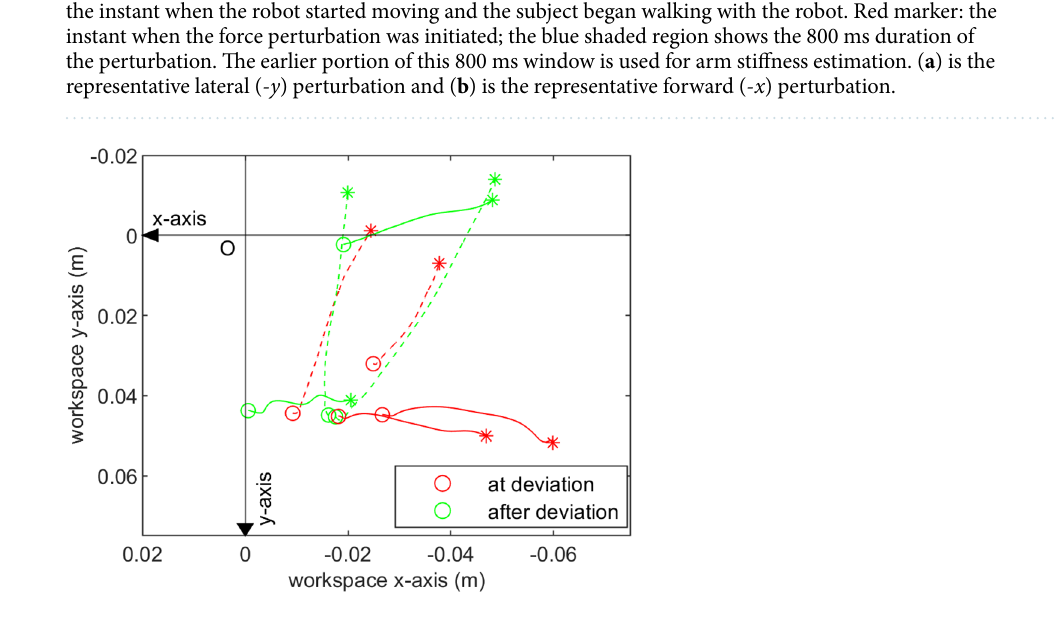
Figure 3. The hand movement trajectories from block 1 of subject 1. The hand is at the circle (o) at the perturbation onset and is displaced to the asterisk (*) after 300 ms. Red and green colors represent the perturbation applied during ‘at deviation’ and ‘after deviation’ trials, respectively. The solid and dotted lines represent the hand movement due to the forward (- x ) and lateral (- y ) perturbations,